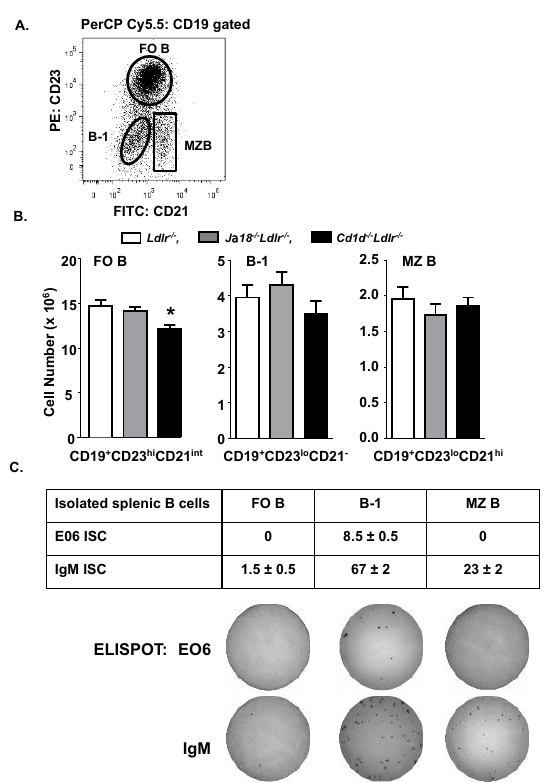
Figure 3. B-1 cells are not increased in the spleen of Cd1d − / − Ldlr − / − mice. ( A ) Representative flow cytometric analysis of splenic B cells subsets. ( B ) Based on the percent of cells in the indicated populations and the total number of splenocytes, the number of CD19 + CD23 hi CD21 int (FO B cells), CD19 + CD23 lo CD21 − cell (B-1 cells), and CD19 + CD23 lo CD21 hi (MZ B cells) in the spleens of chow-fed female Ldlr − / − , J α 18 − / − Ldlr − / − and Cd1d − / − Ldlr − / − mice were quantitated. The results are the mean ± SEM of n = 13–14 pooled from four independent experiments. Significance: * p = 0.002 vs. Ldlr − / − mice. ( C ) Splenic B cell populations in Cd1d − / − Ldlr − / − mice isolated by FACS as outlined in ( A ) were analyzed for E06 ISC or total ISC by ELISPOT. The results are the mean ± SEM of one experiment with cells isolated from two mice analyzed in